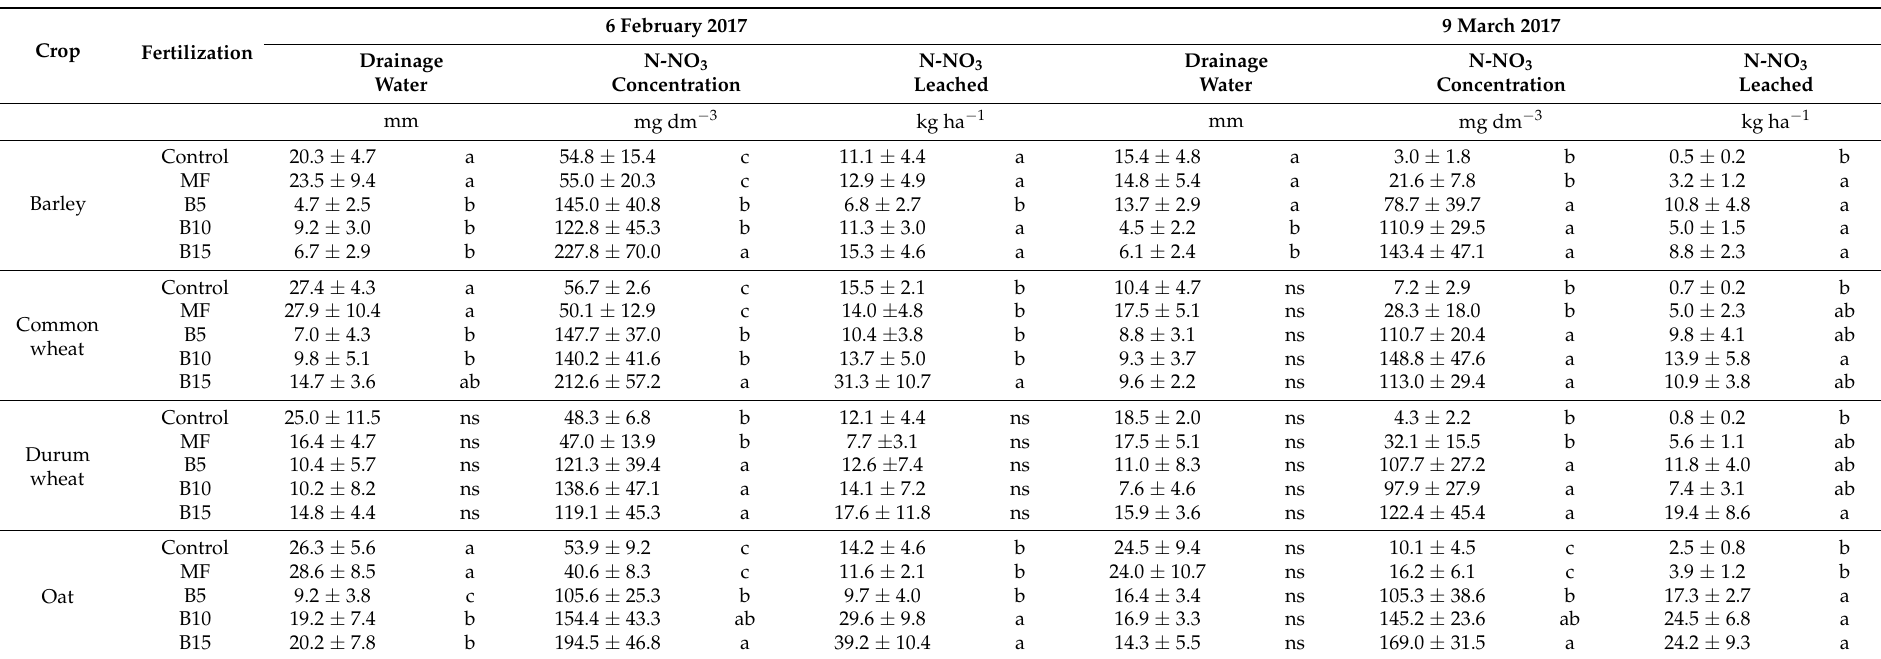
Table 7. Drainage water, N-NO 3 concentration, and N-NO 3 leached in the two leaching events (2017), as affected by fertilization treatment in barley, common wheat, durum wheat, and oat. Crop Fertilization